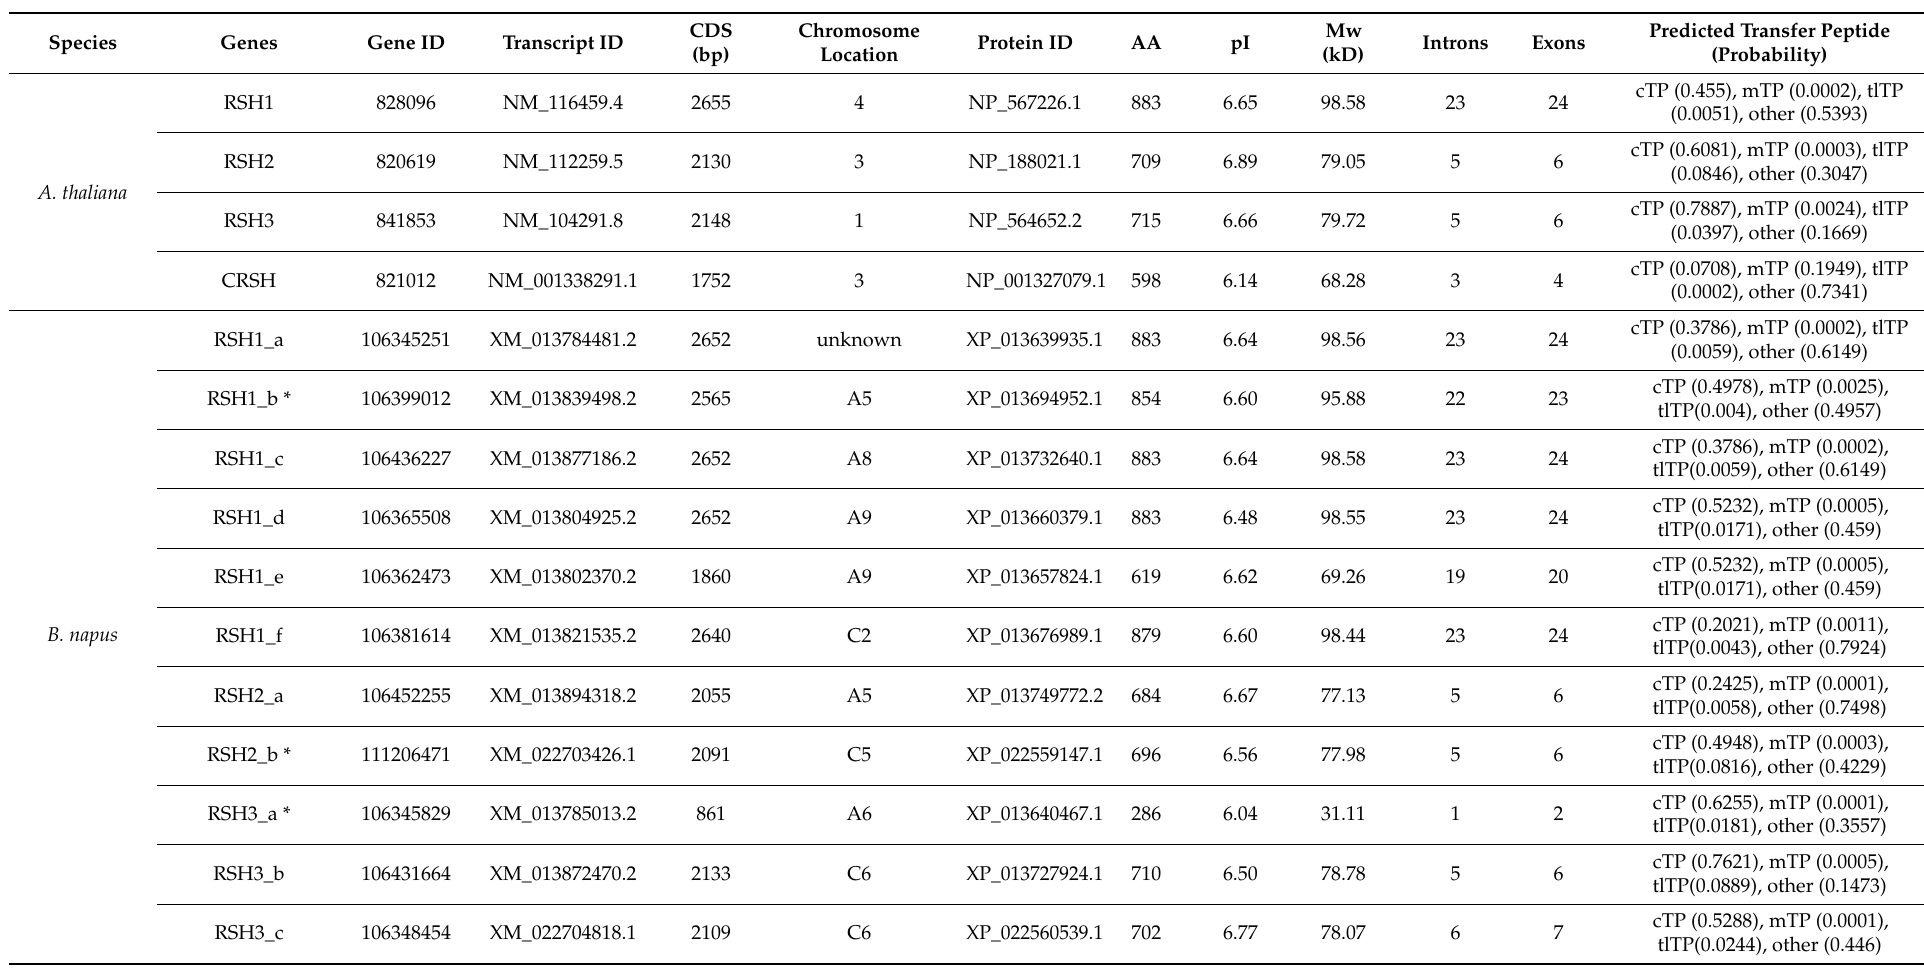
Table 1. RSH genes present in the genomes of A. thaliana , B. napus , B. oleracea , B. rapa , C. sativa , and R. sativus . As a comparison, bacterial proteins of the stringent response for E. coli , RelA and SpoT, and for Streptomyces coelicolor , Rel, were included. The number of exons and introns, the length of CDS, the length, molecular weight, pI, and predicted subcellular localization of putative RSH proteins, are also given. Asterisks (*) indicate the B. napus ( RSH1_b , RSH2_b , RSH3_a , and CRSH ) genes that were further analysed for their expression level (vide infra).